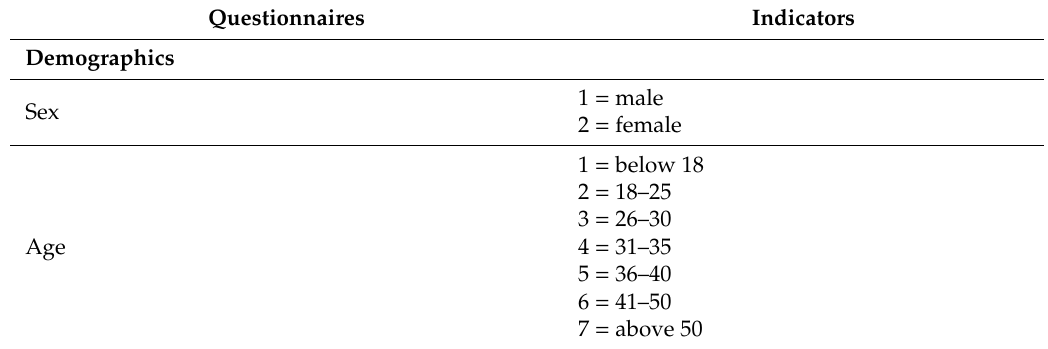
Table A1. Questionnaire